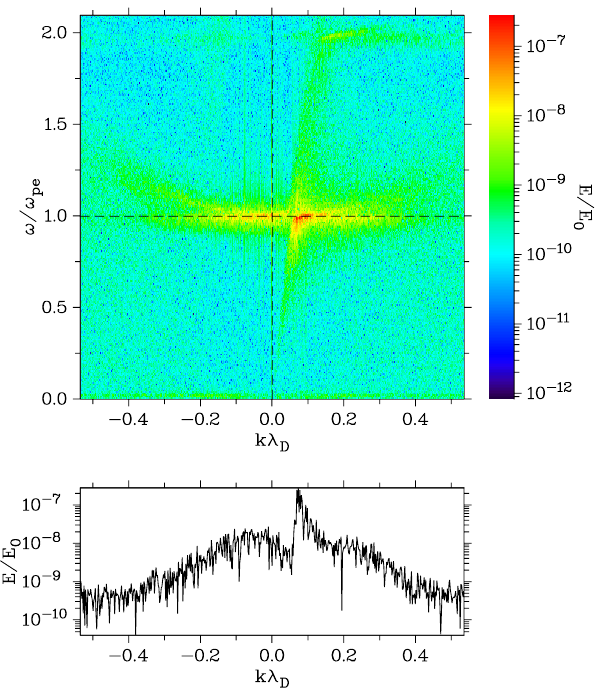
Figure 3. ω − k dispersion diagram for the longitudinal field within the time interval 0 < t < 750 ω − 1 pe (top) and cut through the plot for the frequency ω/ω pe ≈ 0 . 99 for which the mother wave attains its maximum amplitude (bottom). Backscattered Langmuir waves appear for kλ D < 0. Parameters as in Fig.